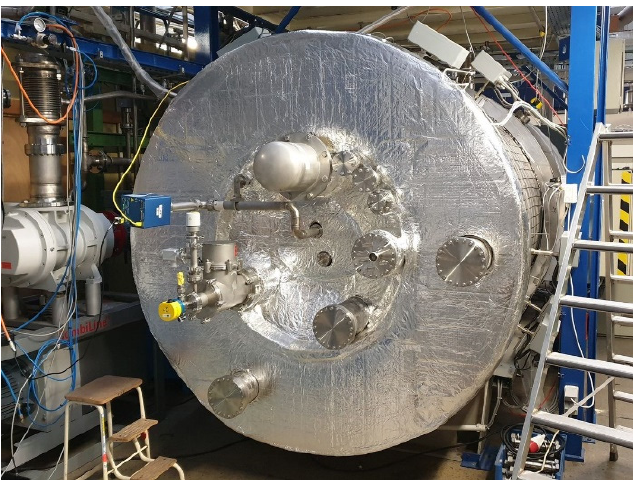
Figure 6. Schematic diagram of the TIMO facility with gas dosage, pressure gauges, auxiliary pump- ing system and the getter pump itself (with thermocouples (TC) and filaments).